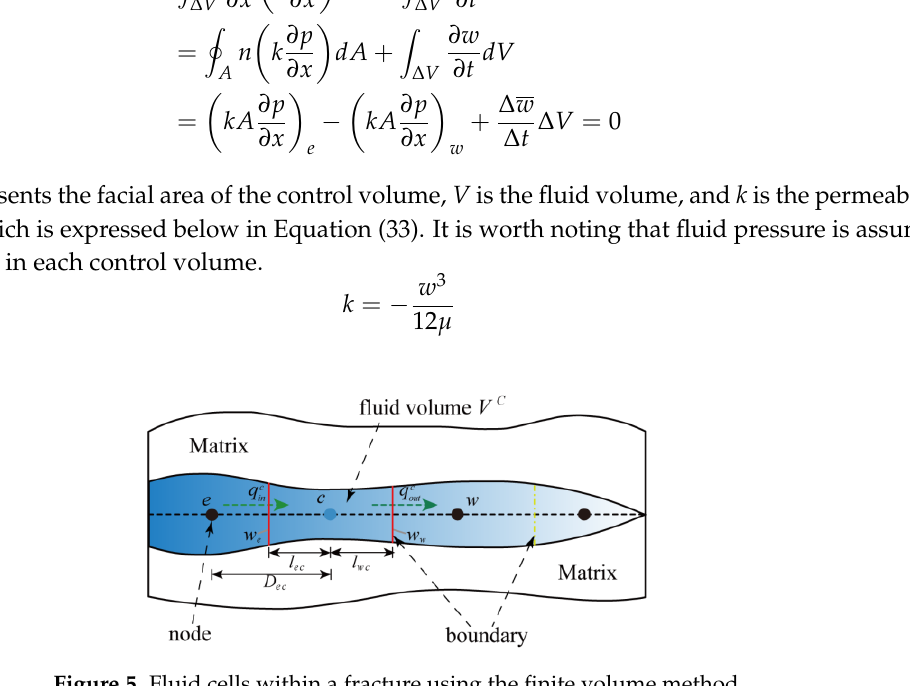
Figure 5. Fluid cells within a fracture using the finite volume method.